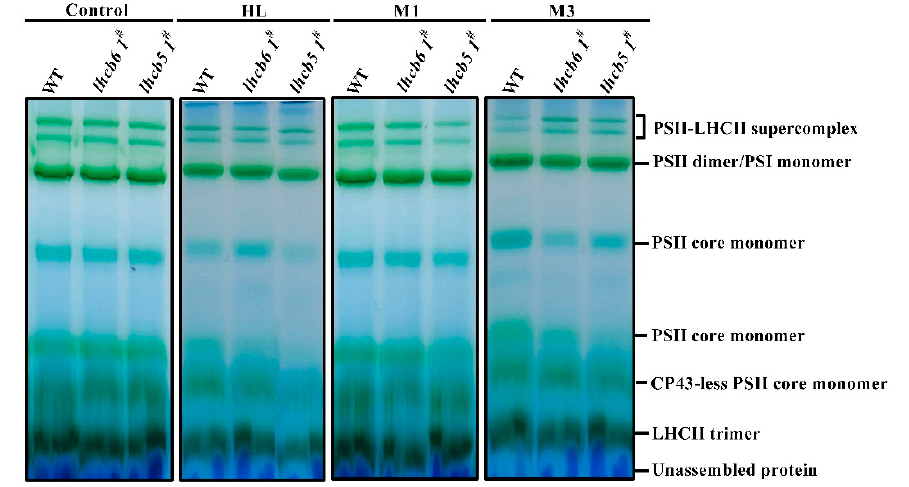
Figure 5. Analysis of pigment-protein complexes in wild-type and mutants by BN-PAGE gel. A freshly isolated thylakoid membrane of wild-type and mutants were solubilized with 1% DM at a chlorophyll concentration of 25 µ g. HL means high light stress for 3 h. M1 or M3 means plants under 500 mM mannitol for 1 day or 3 days, respectively. Assignments of the thylakoid membrane macromolecular protein complexes, indicated on the right, were identified according to a previous study [25].